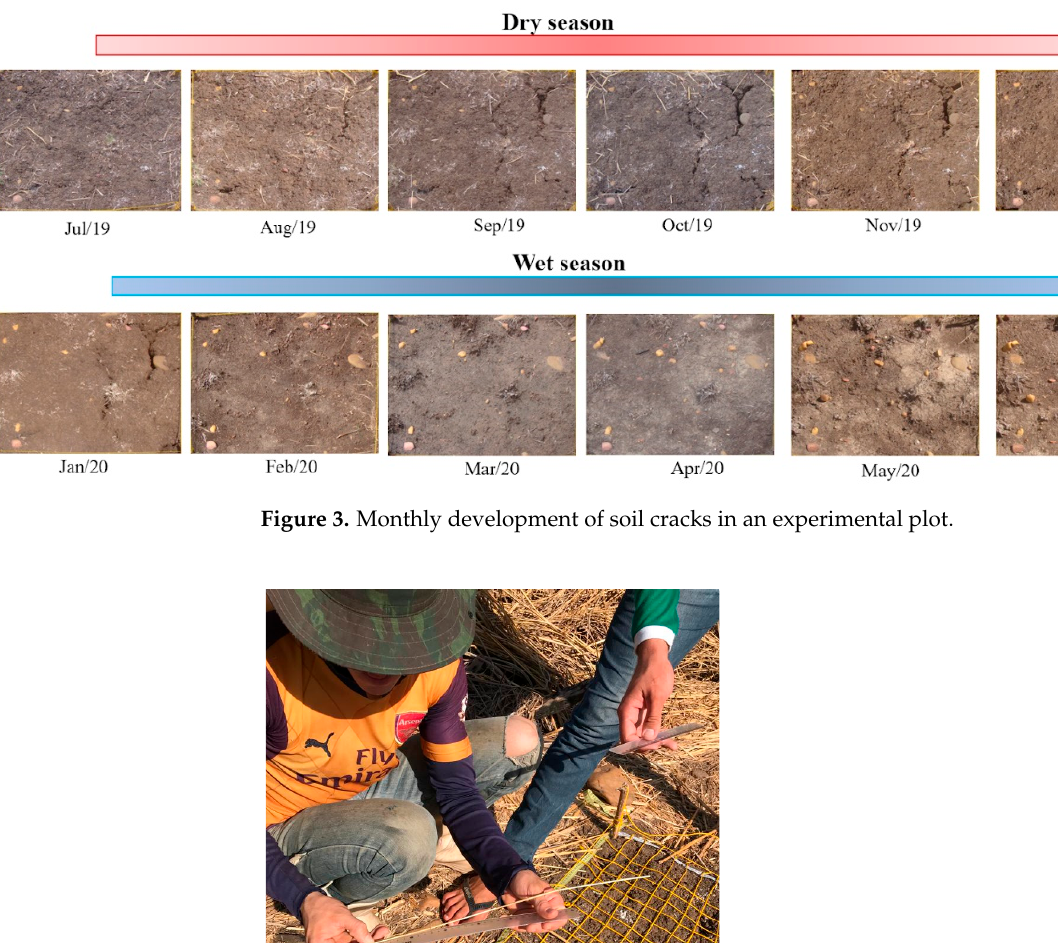
Figure 4. Crack monitoring in situ .